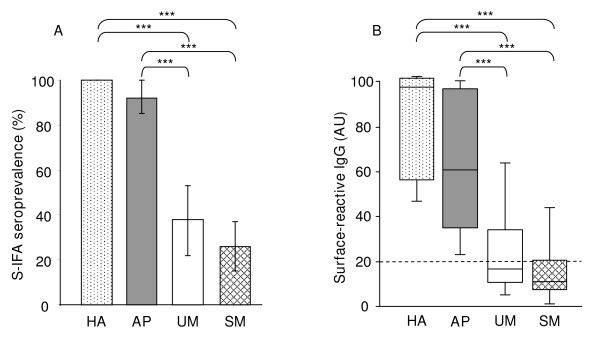
Surface-reactive antibodies to single-variant culture of VarO-IE. Plasma samples were obtained from healthy adults (HA, n = 30) and children with asymptomatic P. falciparum infection (AP, n = 52), uncomplicated (UM, n = 37) or severe (SM, n = 65) malaria. For each child, antibodies (total IgG) reacting with the surface of live VarO-IE were analyzed by S-IFA and flow cytometry. Results are expressed in arbitrary units (AU, see Materials and Methods). (A) Prevalence (95% CI) of surface-reactive antibodies to VarO parasites in the four groups of individuals: HA, AP, UM or SM. (B) Surface reactivity levels in HA, AP, UM or SM children. Box-whisker plots illustrate medians with 25th and 75th percentiles, and whiskers for 10th and 90th percentiles. The outlying dots indicate values exceeding the 90th and 10th percentiles. The P values were estimated using the χ2 test (A) and the nonparametric Man-Whitney U-test (B). ***, P < 0.0001.